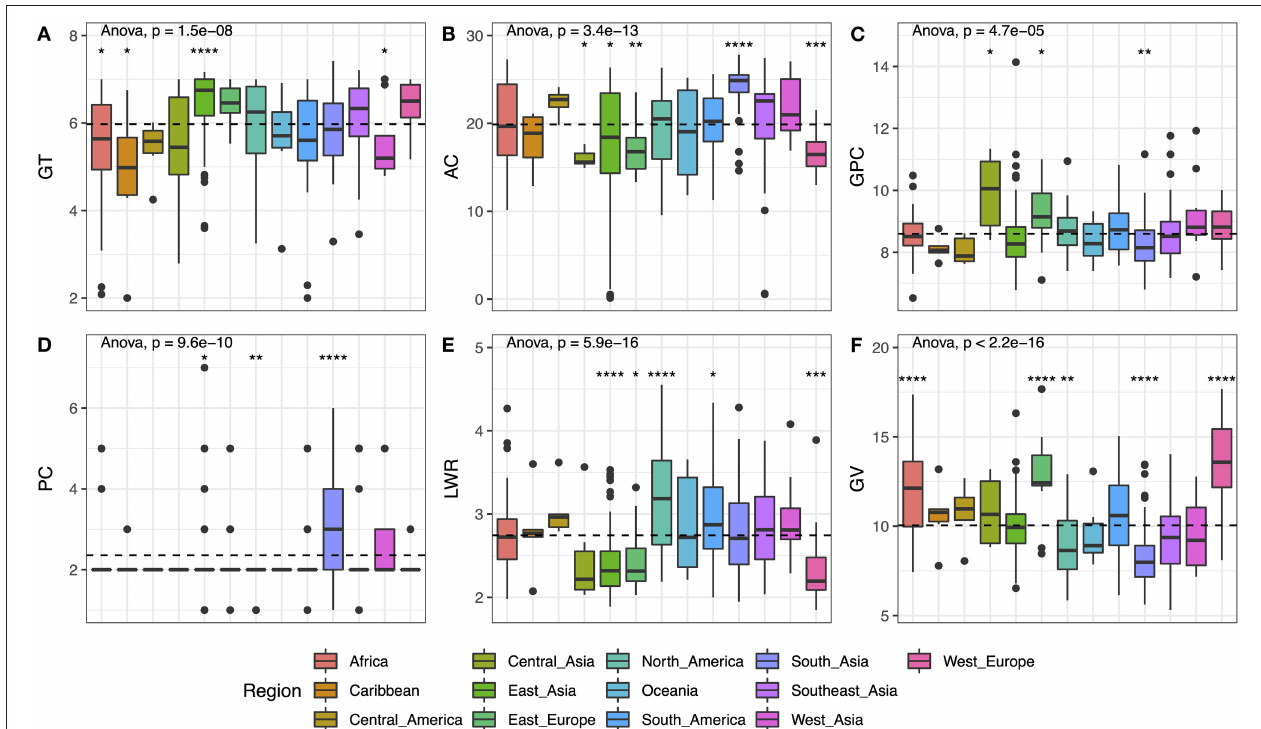
FIGURE 2 | Phenotypic variation of six traits based on different geographical regions. (A) GT, (B) AC, (C) GPC, (D) PC, (E) LWR, and (F) GV. Box plots show the distribution of the traits in subgroups. The numbers of accessions originated from Africa, Caribbean, Central America, Central Asia, East Asia, East Europe, North America, Oceania, South America, South Asia, South Asia, Southeast Asia, West Asia, and West Europe are 40, 7, 7, 7, 85, 16, 46, 7, 32, 68, 51, 12, and 22, respectively. Whiskers represent 1.5 times the interquartile of the data. The upper and lower edge of the box presents the interquartile range of the data. The thick black bar in the center represents the median of the data. The one-way ANOVA test is used to determine whether there are any statistically significant differences between the subgroups, and the p -value is shown on the left corner of each figure. The total population acts as a reference group, and each subgroup is compared with the reference group. Different symbols above each subgroup indicate significant differences: * p < 0.05, ** p < 0.01, *** p < 0.001, and **** p < 0.0001. The dashed black line represents the mean value of the whole